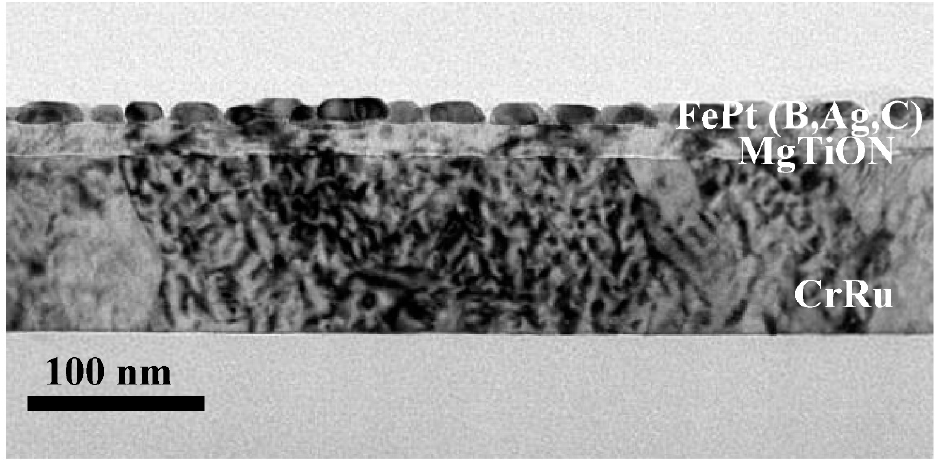
Figure 8. The cross-sectional TEM images of FePt-(B, Ag, C)(8 nm)/MgTiON/CrRu film. To understand the correlation between the magnetic switching behavior and grains’ morphology, we analyzed the switching field distribution (SFD), which comes from the intrinsic and extrinsic contribution of magnetic grains. Figure 9 shows the major and minor magnetization loops of the FePt(B, Ag, C)(8 nm) film, and the intrinsic ( ∆ H int = 12.6 kOe) and extrinsic ( ∆ H ext = 1.62 kOe) switching field distributions were determined. The recoil loop in the coercivity field means the switching of 50% of the grains in the easy axis, and the demagnetization field between the grains, were neglected. As compared to the major magnetization loop, the parameters ∆ H int and ∆ H ext were collected. The intrinsic SFD arises from grain size distribution ( σ volume ), magnetocrystalline anisotropy dispersion ( σ Hk ) and misalignment of the c-axis( σ axis ), and the extrinsic SFD comes from the grains’ dipolar and exchange coupling [4,17]. The standard deviation ( σ int ) of intrinsic SFD is 9.33 kOe (~21.2% of H k ), estimated from the ∆ H int /1.35 [4,17], and the ( σ int ) 2 can be written as the summary of ( σ volume ) 2 + ( σ axis ) 2 + ( σ Hk ) 2 , which was the result of individual